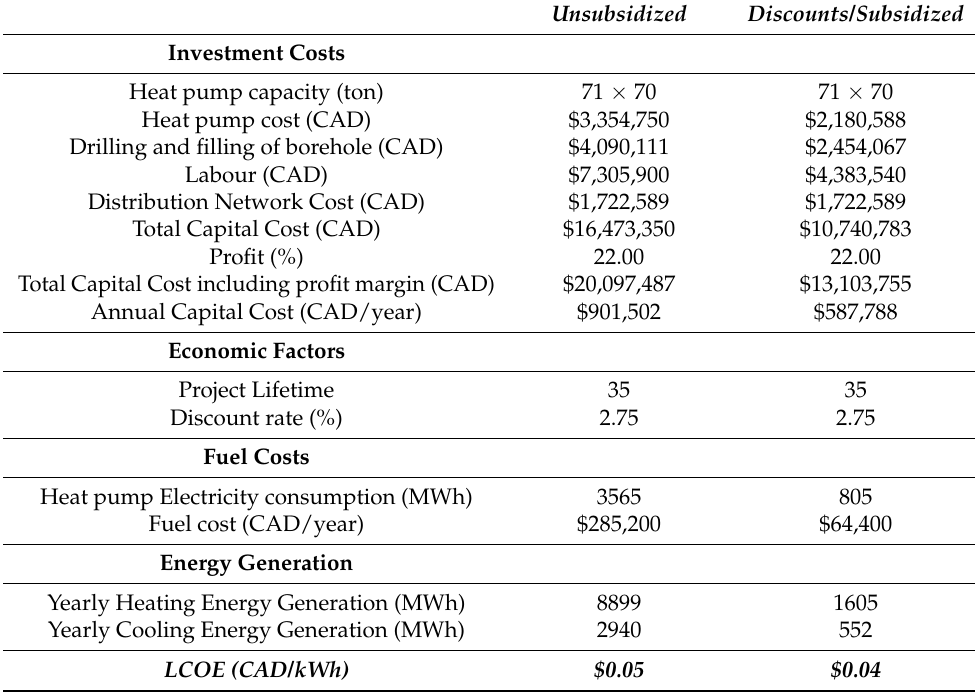
Table 8. Economic assessment of the second scenario (centralized energy